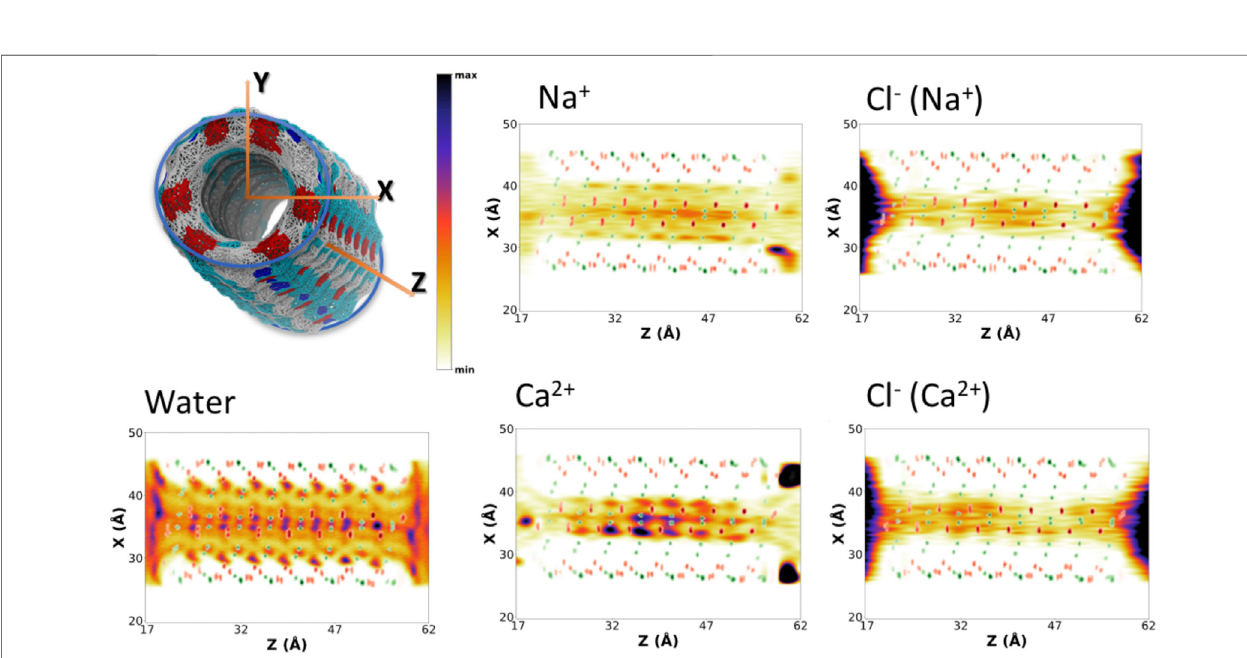
FIGURE 5 | Positional probability distributions represented as heatmaps (increasing from orange to blue) at the XZ plane for Na + , Ca 2+ , and their correspondent counter Cl − anions. Water (from the blank trajectory) is shown at the down left of the fi gure. The averaged position of alpha carbons (green) and carbonyl groups (red) is also represented as a reference. These 2D-heatmaps were generated using the last 180 ns of the MD simulations.